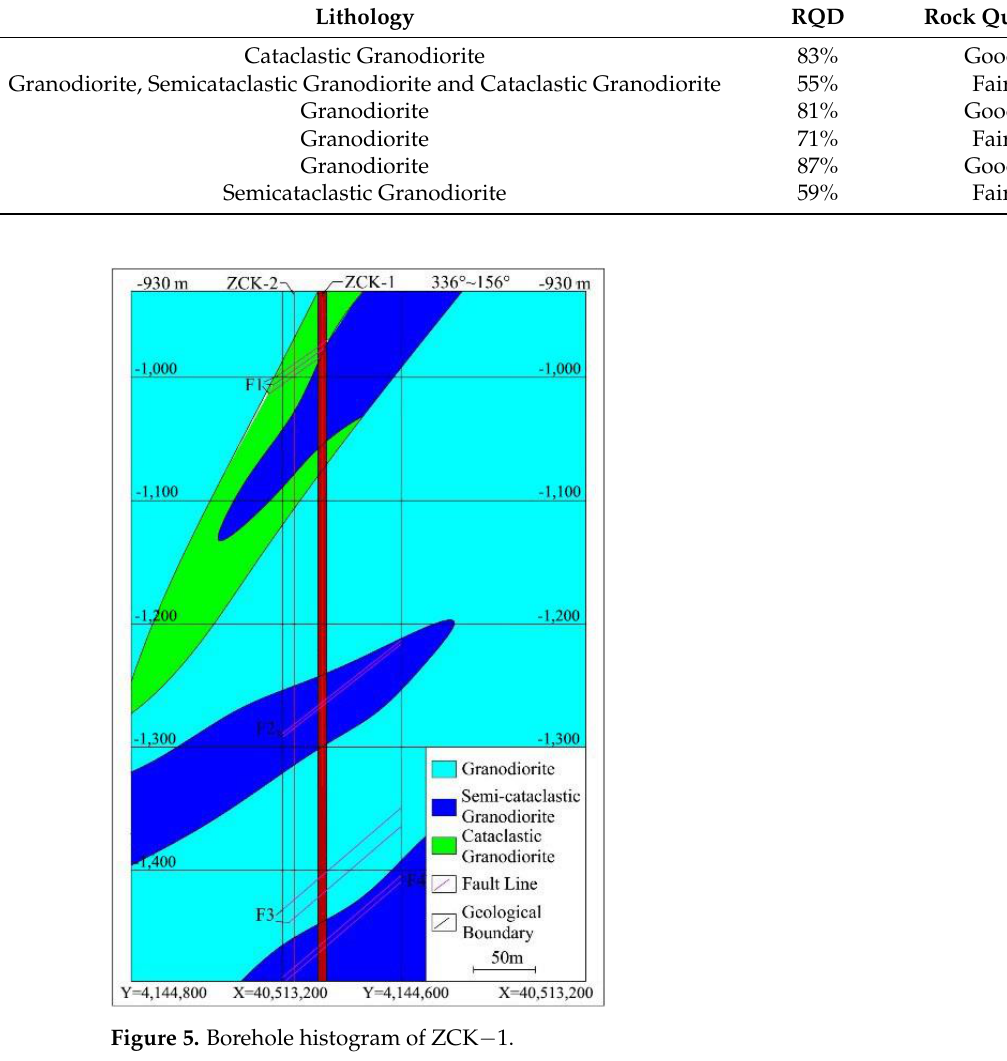
Figure 5. Borehole histogram of ZCK−1.